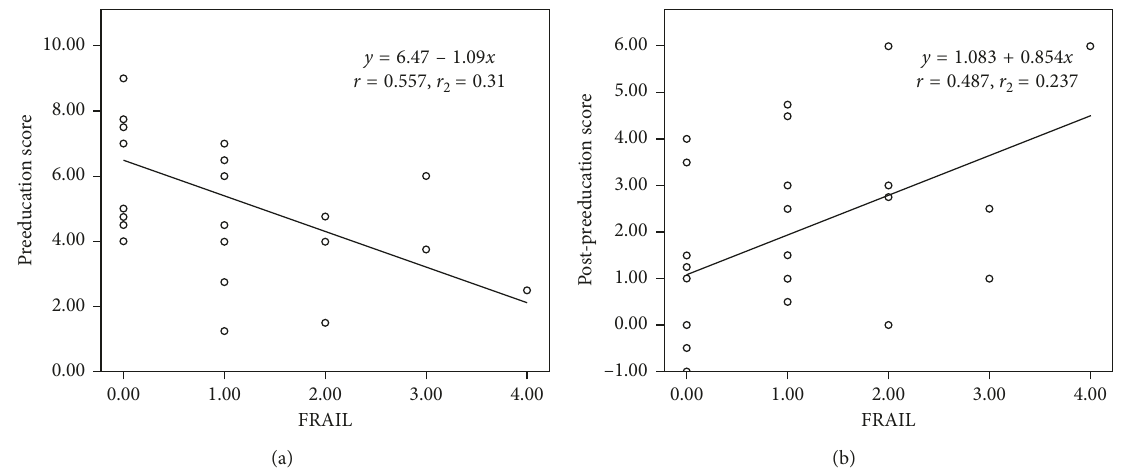
Figure 2: (a) FRAIL score as the predictor of baseline eye drop technique score; (b) FRAIL score as the predictor of the improvement of eye drop technique score after education; multiple linear regression